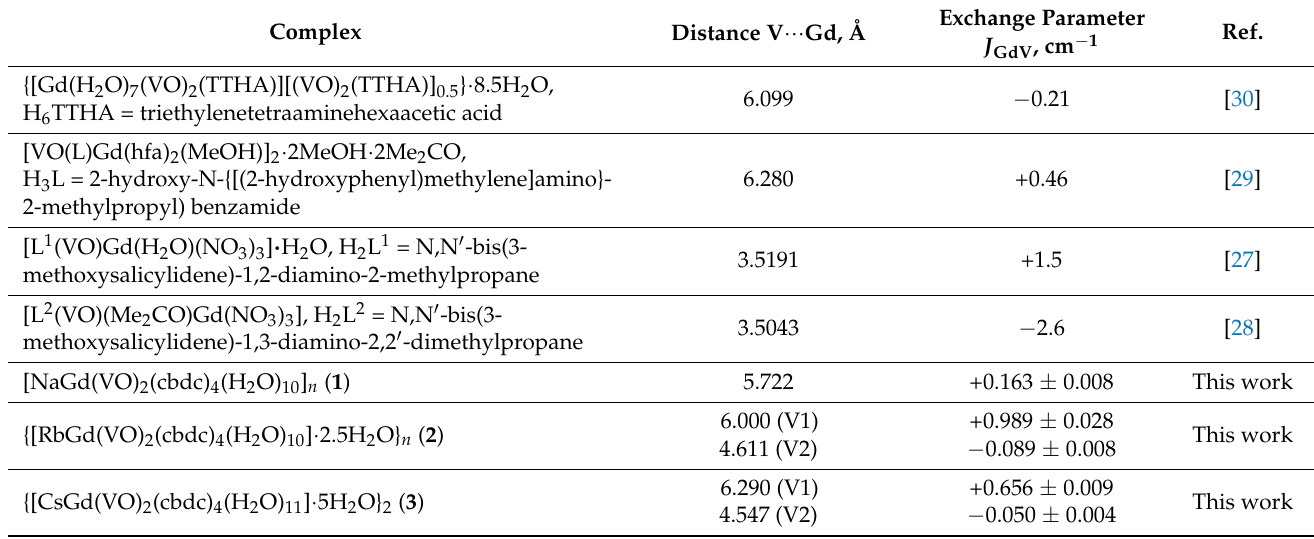
Table 2. Magnetic properties of known Gd III -V IV